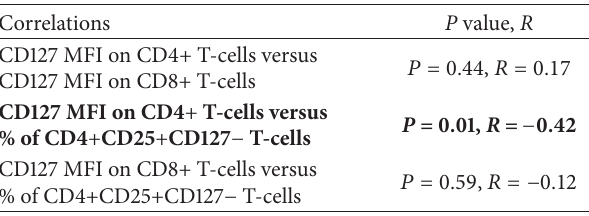
Table 2: Analysis of mutual relationships among CD127 expression on CD4+ and CD8+ T-cells and percentage of CD4+CD25+CD127 − T-cells in T1D